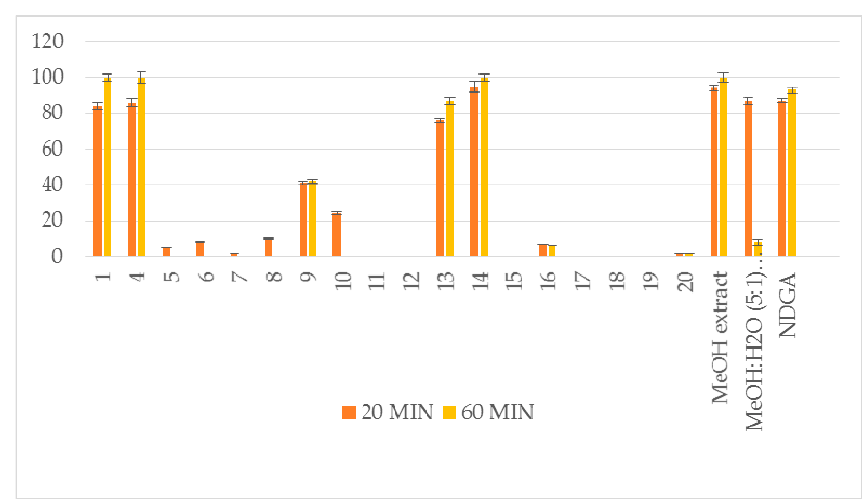
Figure 2. Reducing ability (RA %) at 0.1 mM. Interaction with DPPH.